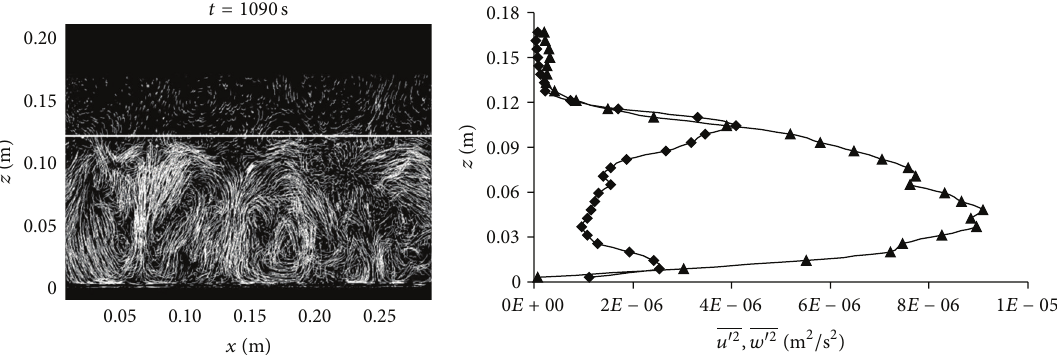
Figure6:TrajectoriesreconstructedbyFTandverticalandhorizontalvelocitycomponentvarianceprofiles(diamondfor 𝑢 󸀠2 ,trianglefor 𝑤 󸀠2 ) compared with the mixing layer height derived quantitatively from temperature measurement and qualitatively from trajectory observations (experiment